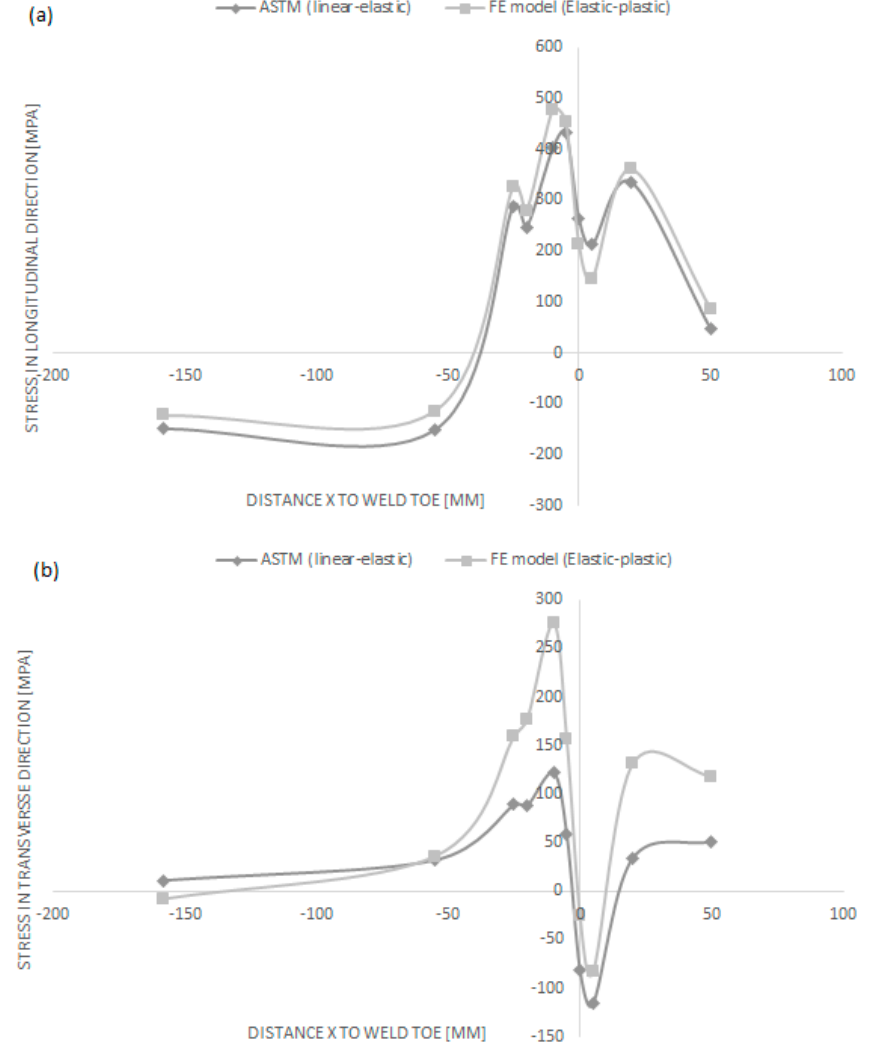
Figure 13. Comparison of residual stress distribution on the top of the deck plate between ASTM and the 3D model in the longitudinal ( a ) and transverse ( b ) directions.